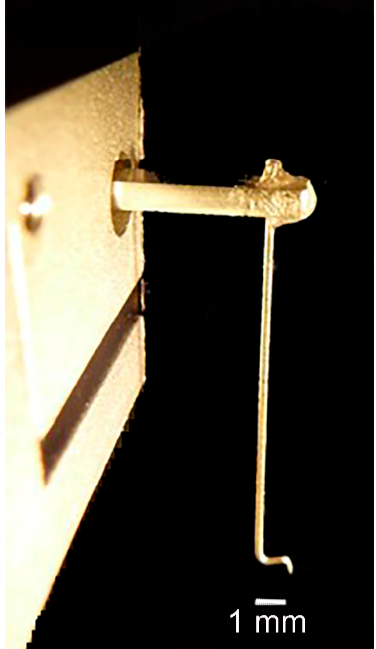
Figure 4. Force transducer “L”-shaped pin design: This pin rests on the bump on the dactylopodite and relays the force to the transducer as the cheliped opens with stimulation.